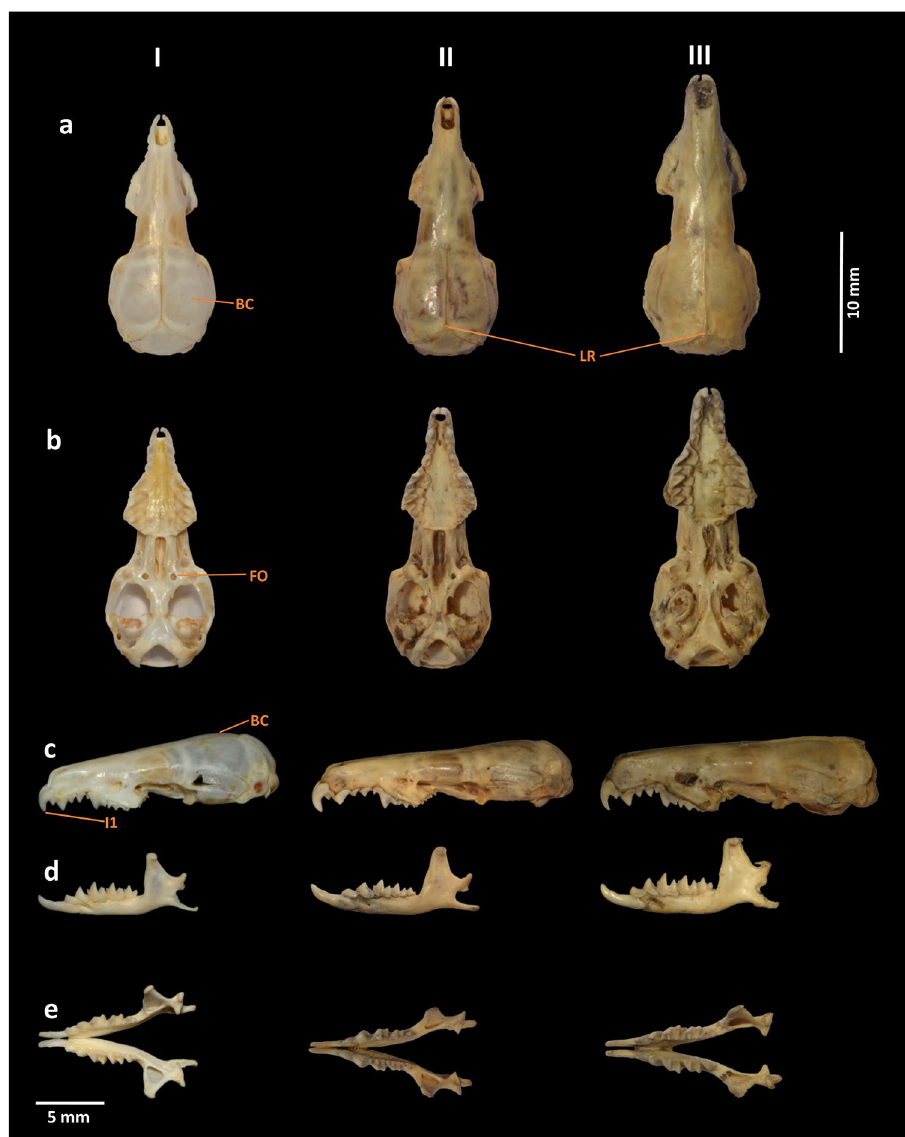
Figure 3. Cranium and mandible of (I) C. narcondamica sp. nov. (holotype, ZSI-28000) (II) C. attenuata (ZSI-16129) and (III) C. jenkinsi (ZSI-19860). From top to bottom, ( a ) dorsal, ( b ) ventral, ( c ) lateral views of the cranium, and ( d ) lateral and ( e ) occlusal views of the mandible. Distinct morphological features are labelled as BC brain case, LR lambdoidal ridge, FO foramen ovale, and I1 first incisor/first unicuspid. The photographs were captured by the first author using a Nikon D7000 camera and edited manually in Adobe Photoshop CS